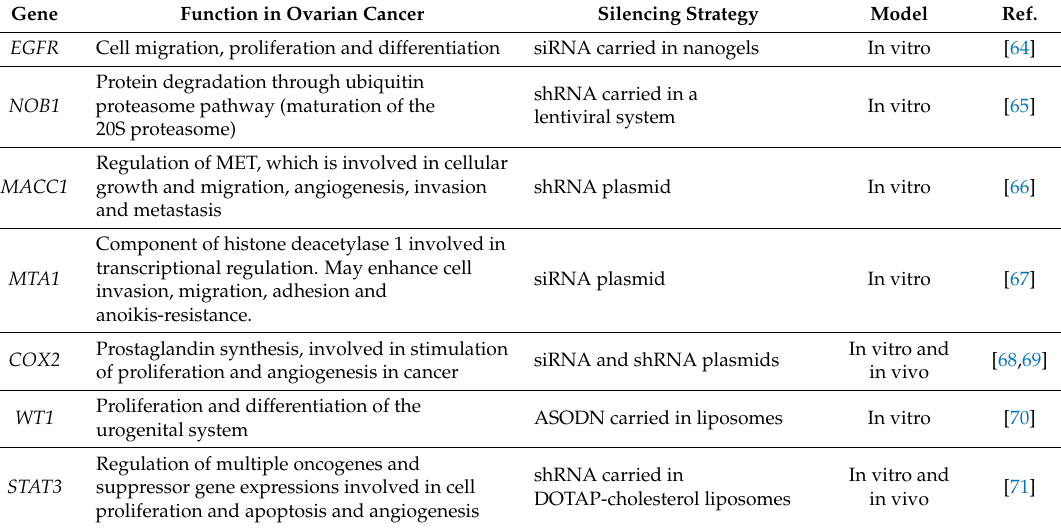
Table 2. Most frequent oncofactor inhibition approaches used in ovarian